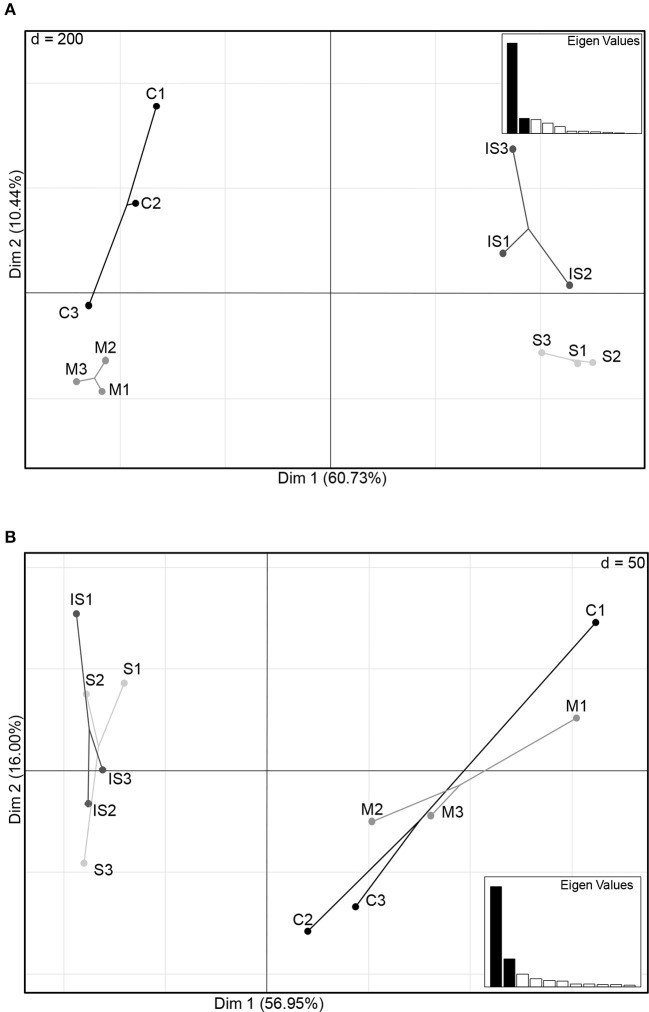
Principal component plots of the conducive soil (C), mixed soil (M), suppressive soil (S), and pathogen-inoculated suppressive soil (IS) generated from fungal (A) and bacterial (B) OTU matrices of ITS1 and 16S relative abundance levels.